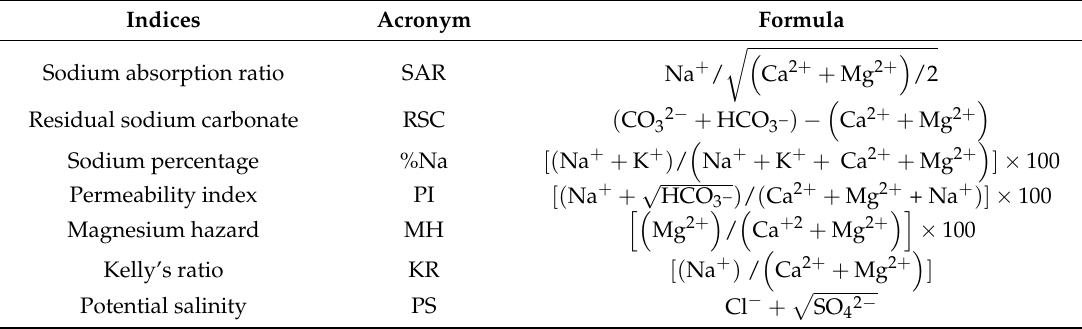
Table 2. Summary of water quality indices for